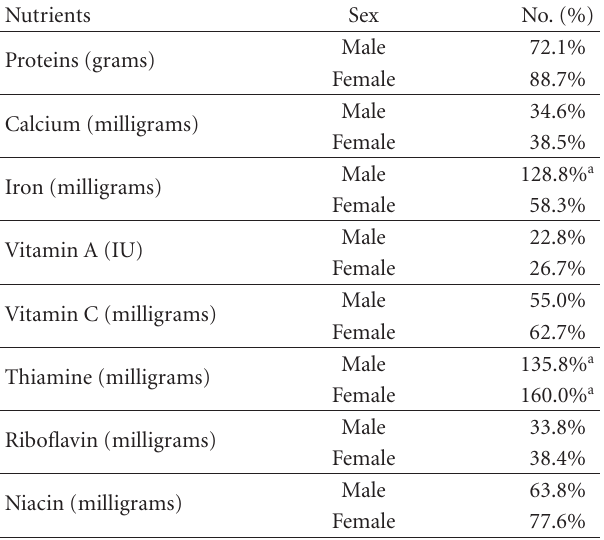
Table 3: Determination of adequacy of nutrient intake among HIV seropositive patients ( n = 497).